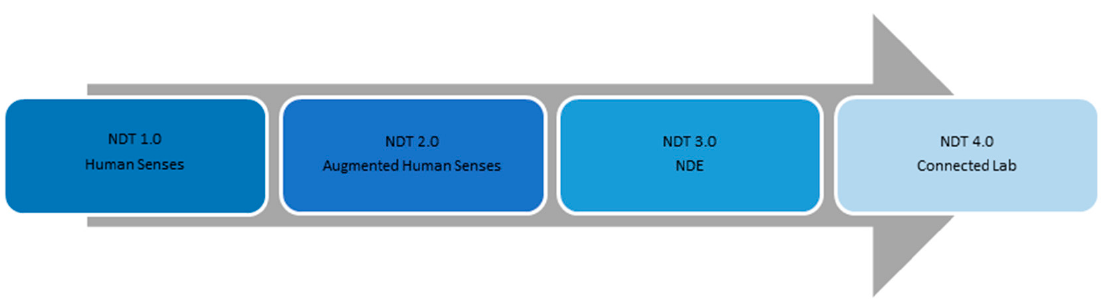
Figure 1. NDT concept evolution.